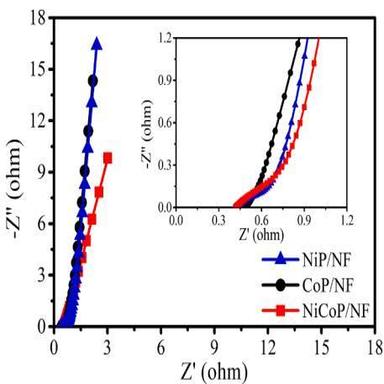
Nyquist plots of the NiP/NF, CoP/NF and NiCoP/NF.